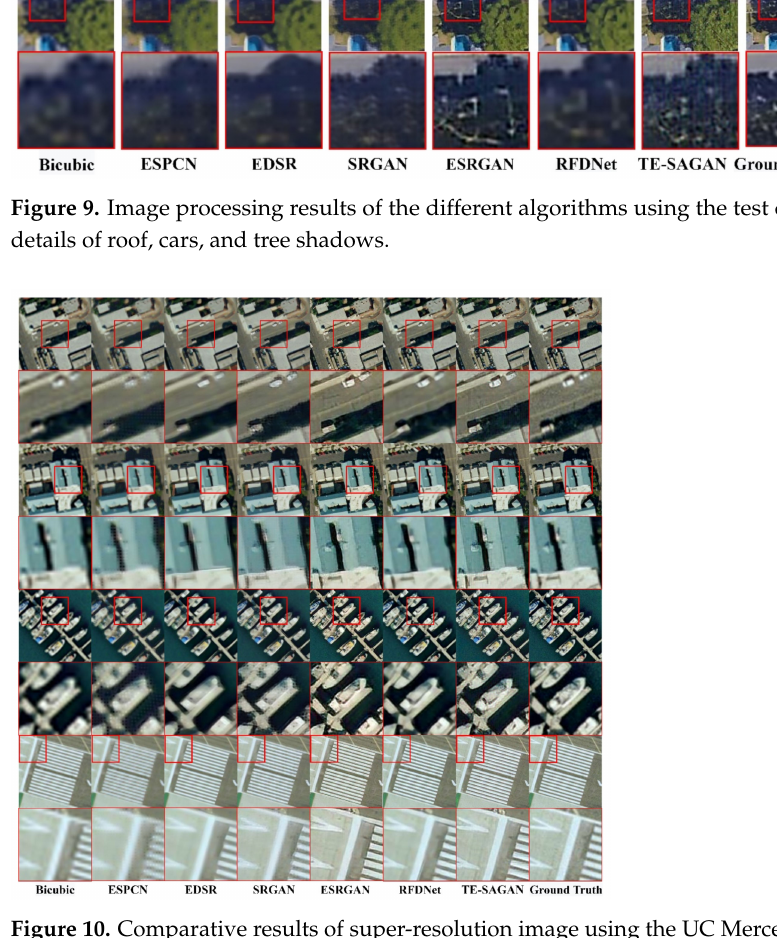
Figure 10. Comparative results of super-resolution image using the UC Merced Land Use